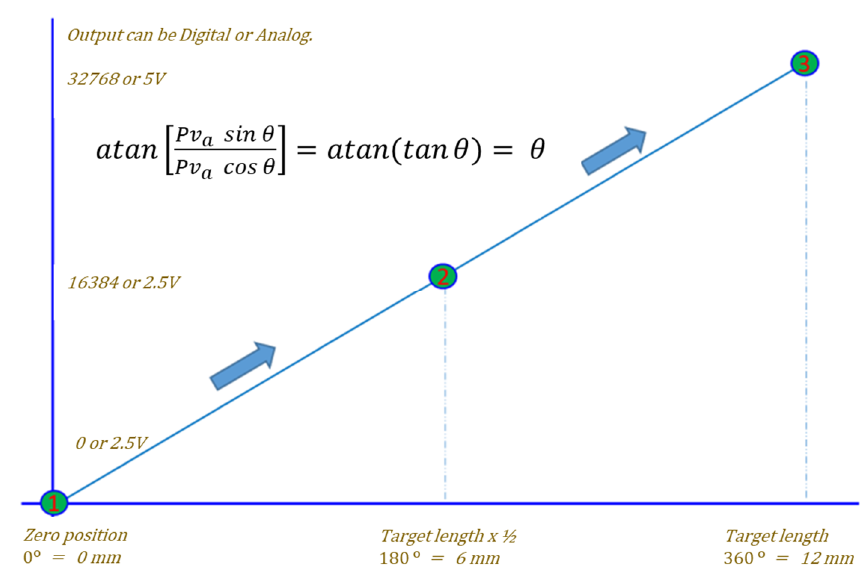
Figure 3. Arctangent computing with linearization result of Figure 2.